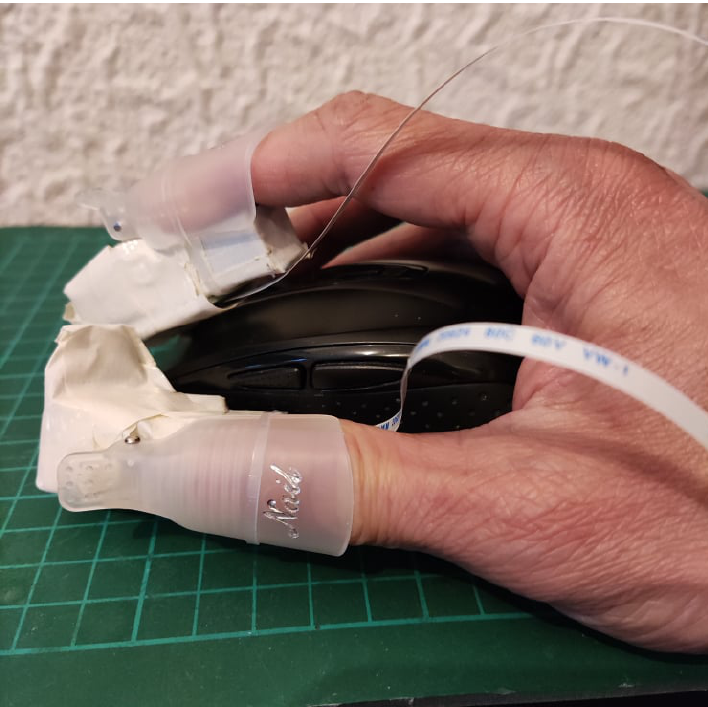
Figure 9. How a mouse can be a tactile mouse: when the user wears our untethered haptic hand wearable. Wireless